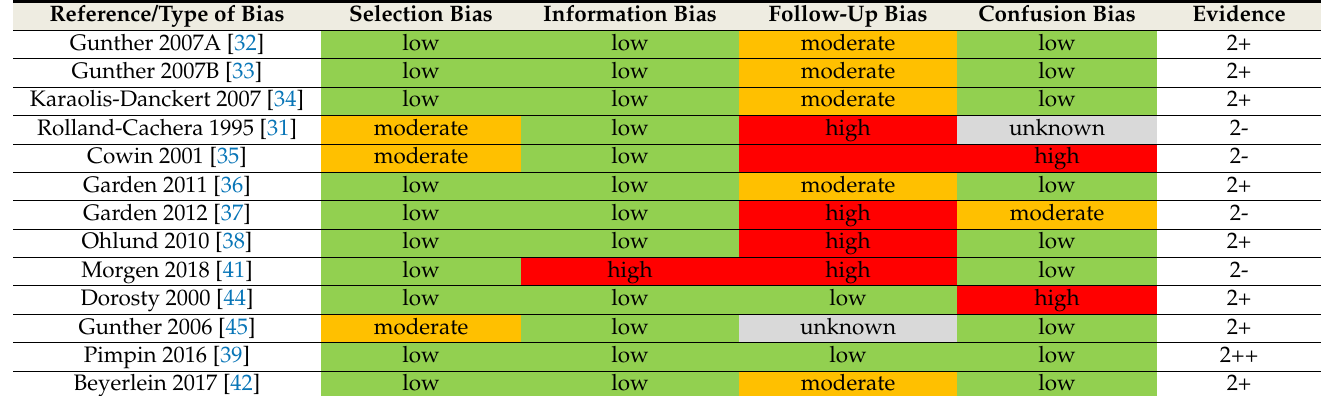
Table A2. Biases from the included cohort studies.